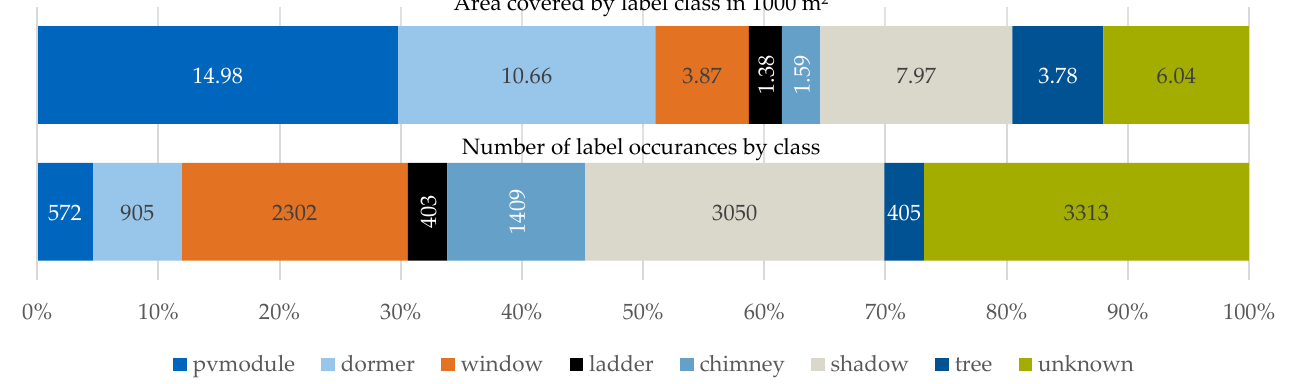
Figure 4. Class distribution of superstructure classes in a 1000 m 2 area and by the number of label occurrences within the dataset.